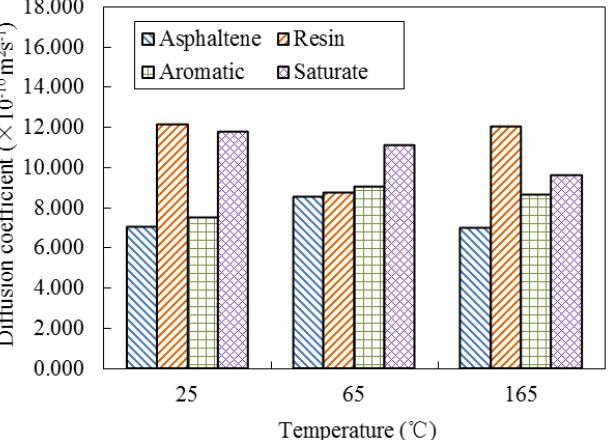
Figure 4. Diffusion coefficient of four asphalt components on the surface of Al 2 O 3 at different temperatures.